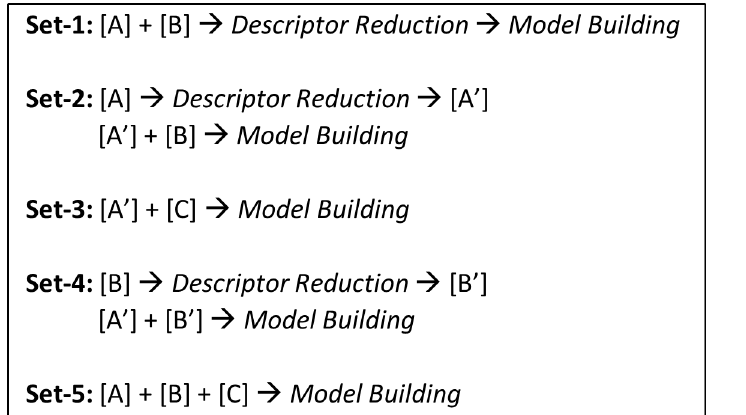
Fig 2. Descriptor sets used for QSAR